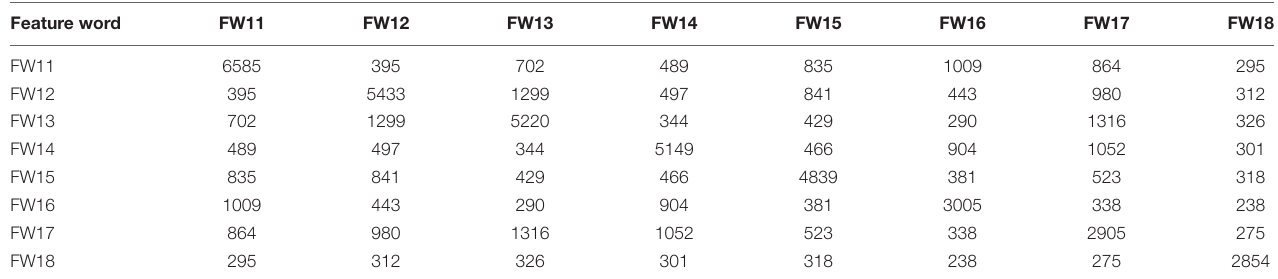
TABLE 2 | The word-to-word co-occurrence matrix date of “Regular Customers Priced High” (topic1). Feature word